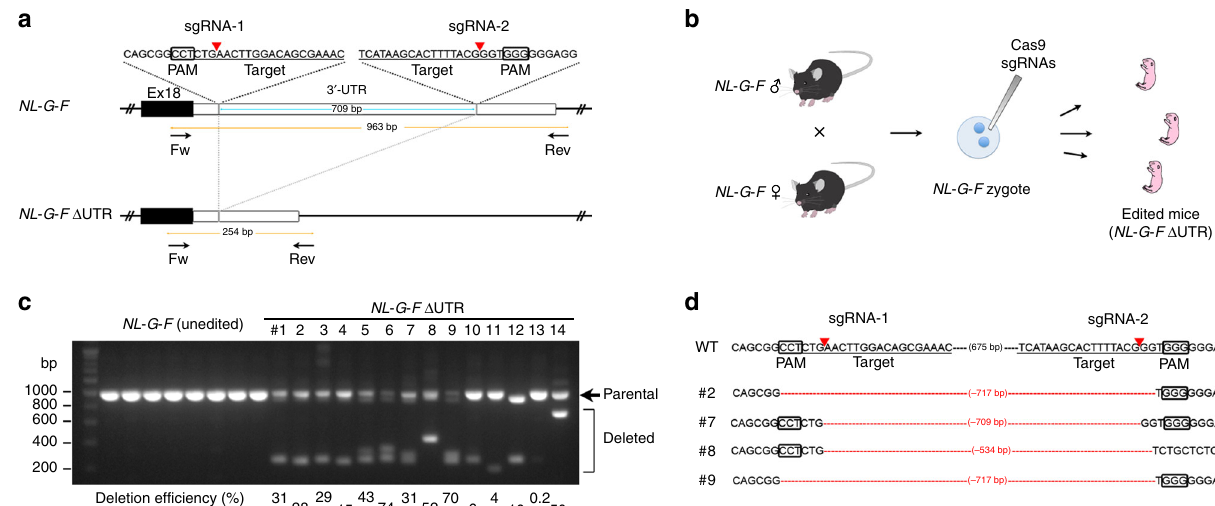
Fig. 1 Disruption of App 3 ′ -UTR in NL-G-F knock-in mice. a Positions of targeting sgRNAs and detection primers used for CRISPR/Cas9-mediated deletion of App 3 ′ -UTR. Red arrowheads indicate Cas9 cleavage sites within the sgRNA target sites. b Strategy for genome editing of homozygous NL-G-F mouse zygotes. c PCR-based genotyping results of NL-G-F Δ UTR mice. Genotyping was performed using mouse brain samples. In contrast to unedited NL-G-F , NL- G-F Δ UTR showed various deletion in the App 3 ′ -UTR. The deletion ef fi ciency was calculated as the relative ratio of the intensity of deleted fragments (parenthesis) to that of parental band (arrow). The ef fi ciency of each NL-G-F Δ UTR mouse is represented on the bottom of each lane. d Exact sequences of cleaved fragments from four representative NL-G-F Δ UTR mice (#2, #7, #8, and #9 from Fig. 1c). PCR products from mouse brain DNA samples were subcloned into the pTAC-1 vector and individual clones were picked and